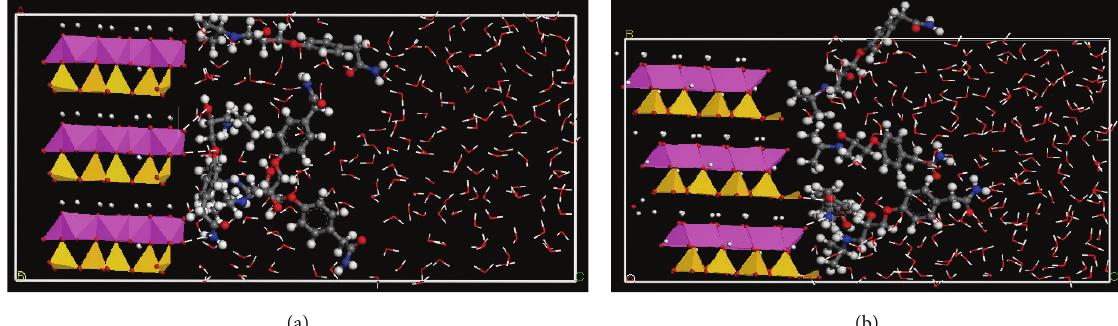
Figure 9: Interactions between AT and kaolinite on (100) (a) and (010) (b). Dashed lines indicate hydrogen